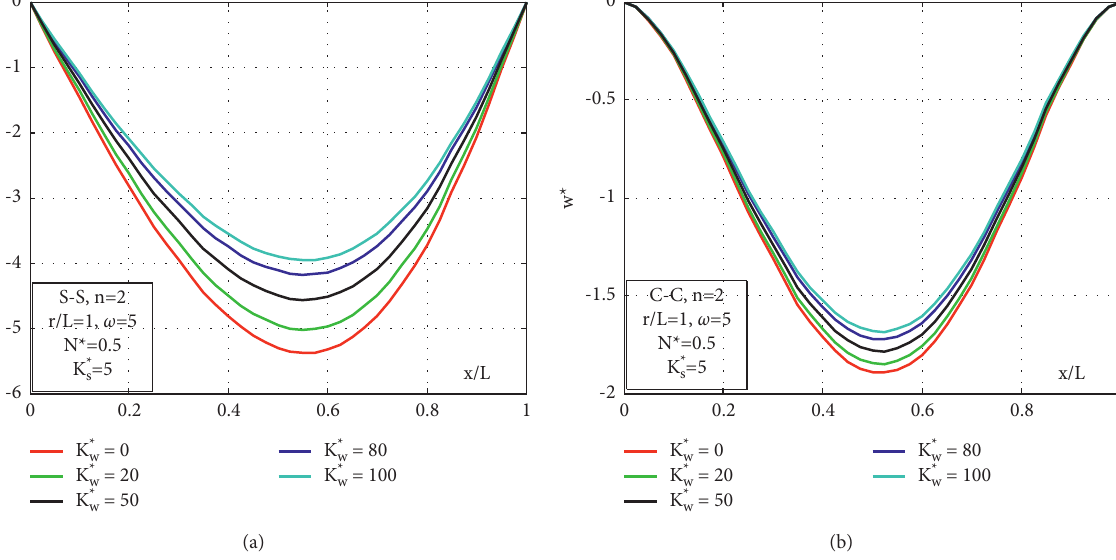
K ∗ � 5. (a) S-S. (b) w and s